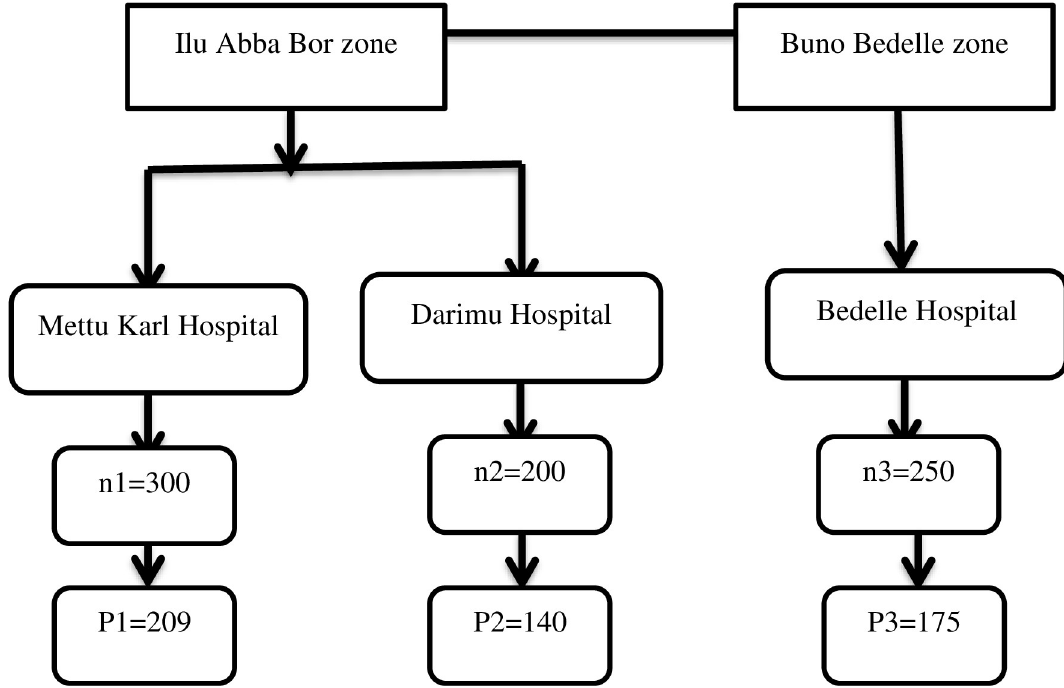
Fig 1. The schematic presentation of the sampling procedure that was employed to select study participants from three zones, southwest, Ethiopia, 2019. Where, n–is the average number of schizophrenic patients who were treated at the psychiatric clinic of each hospital per one month (data collection period) as reviewed from the patients’ registration book. P–is the number of schizophrenic patients who are allocated proportionally to the